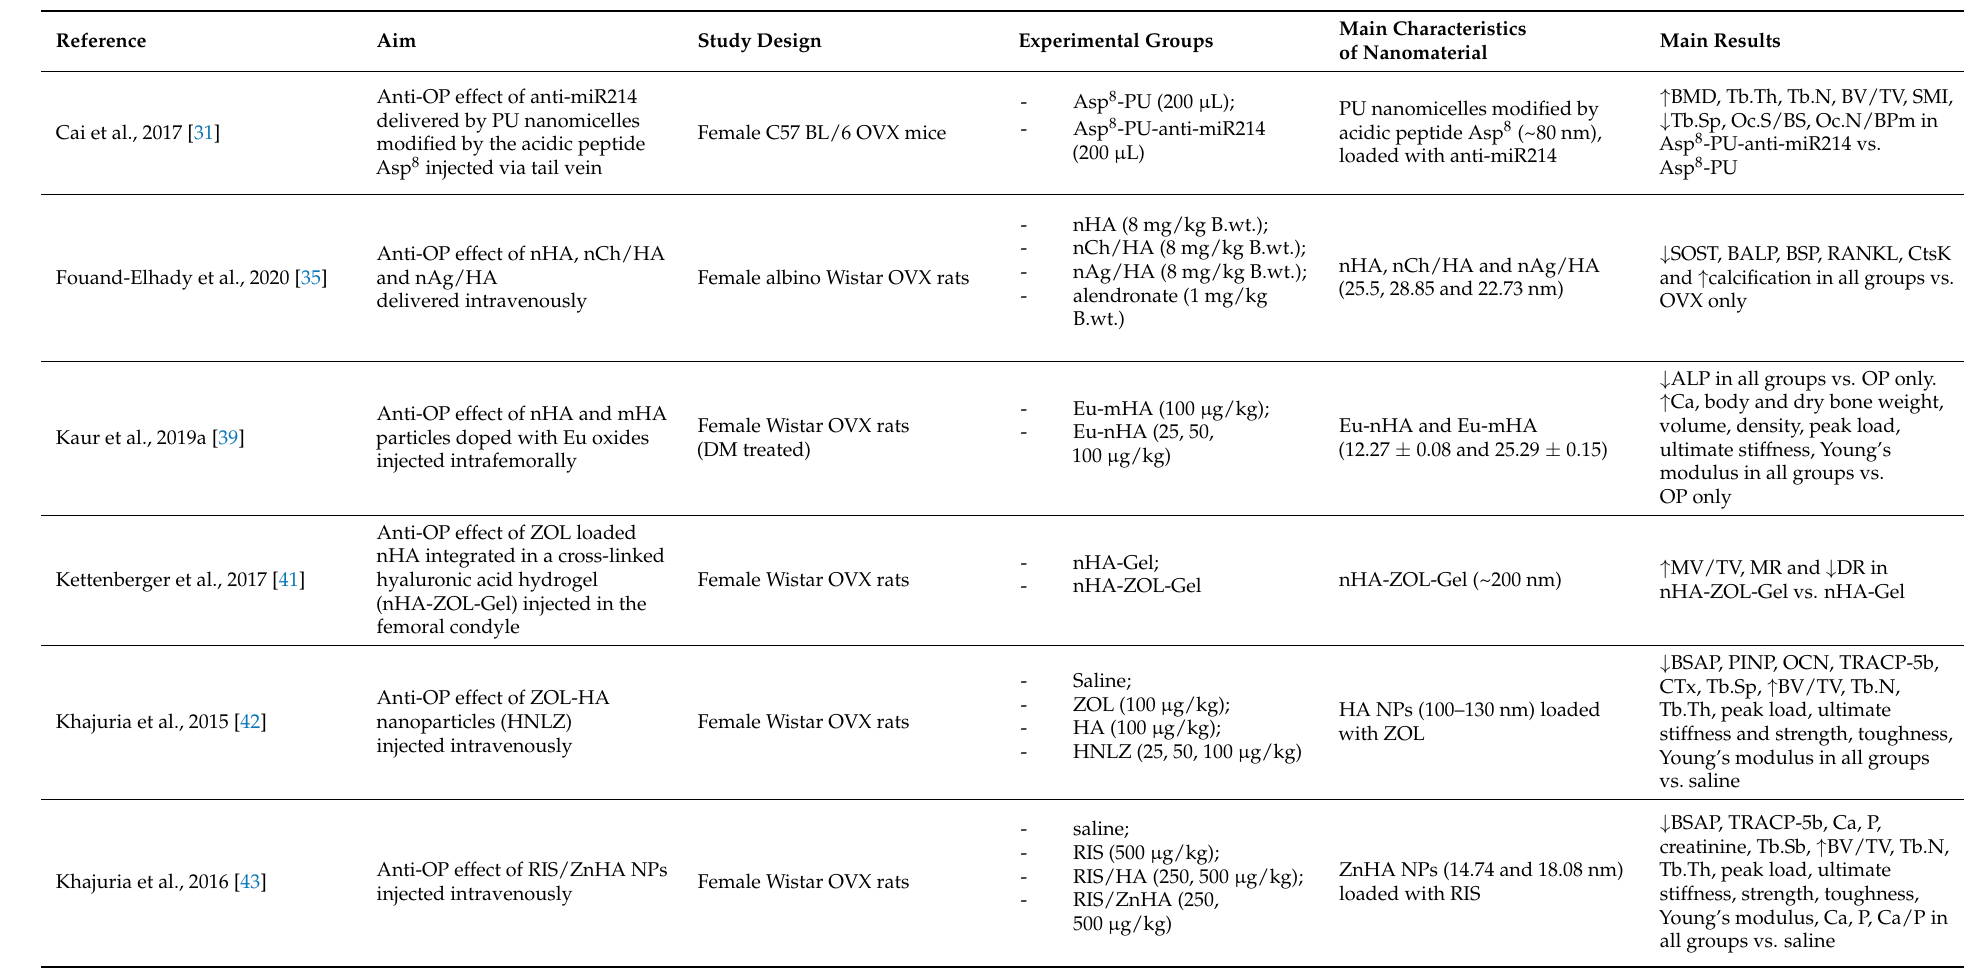
Table 1. Preclinical in vivo studies where the injectable delivery approach was used for the delivery of drugs through nano-based materials in osteoporosis (OP)